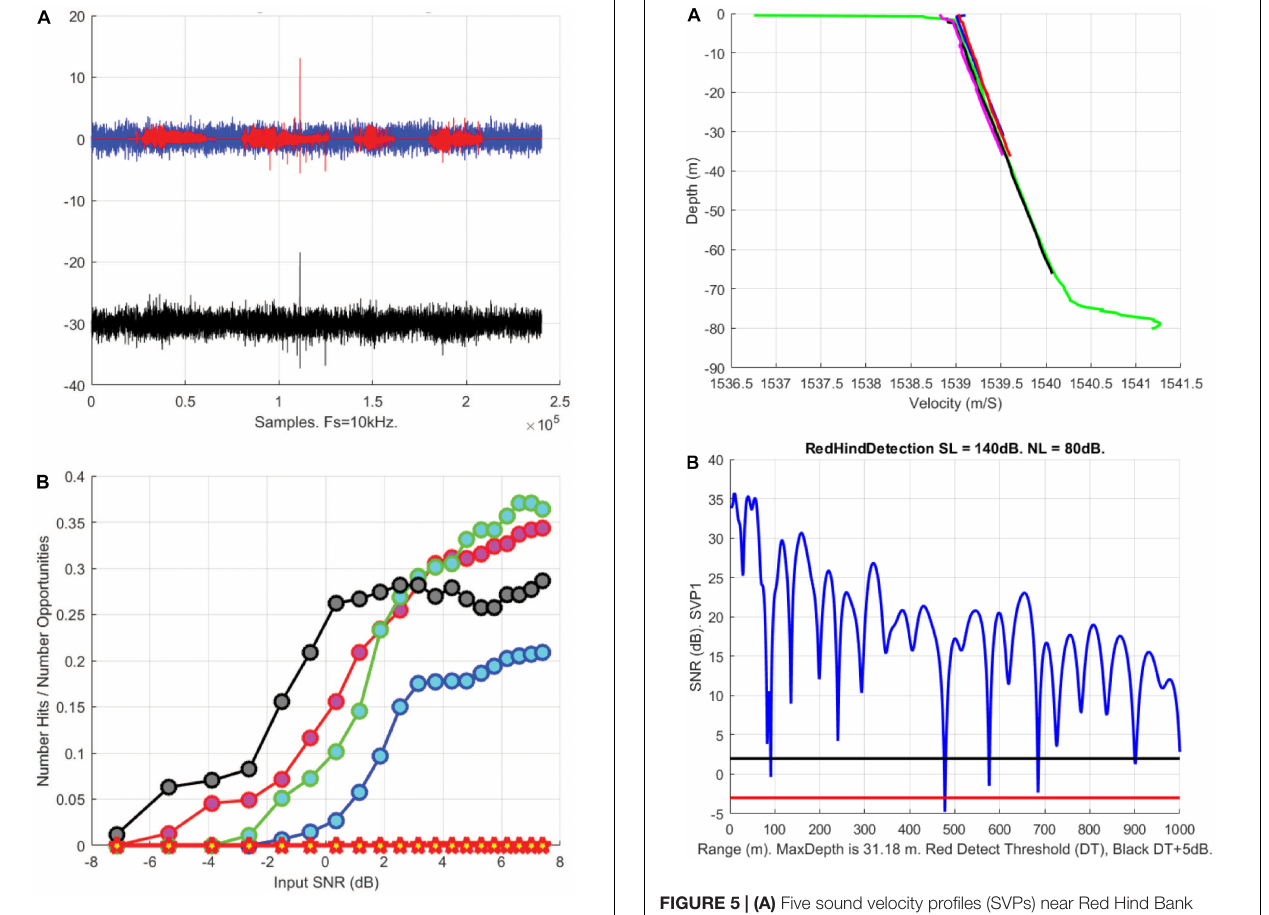
FIGURE 4 | (A) Normalized signals of red hind grouper courtship associated sounds (CAS) received at one of the PAM hydrophones (red) overlaid on normalized noise (blue) corresponding to a signal to noise ratio of –7 dB. Black signal shows the sum of both. Fs stand for sampling frequency. (B) Detection probability (P(D) for each of the four red hind CAS signals shown in (A) . Each colored line corresponds to one of the CAS signals. The red stars indicate a 0 false alarm probability (P(FA) = 0).